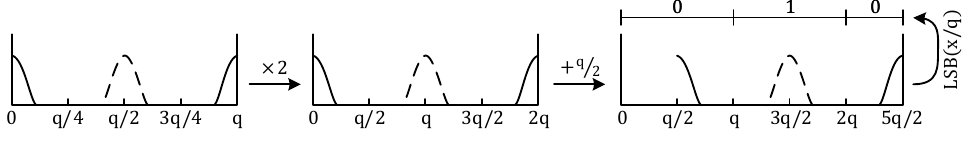
Figure 4: Visualization of the decoding routine used in Kyber’s reference